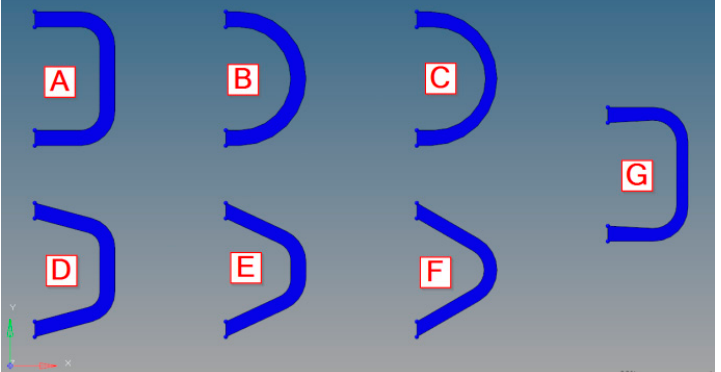
Figure 25. Analyzed blade shape designs.